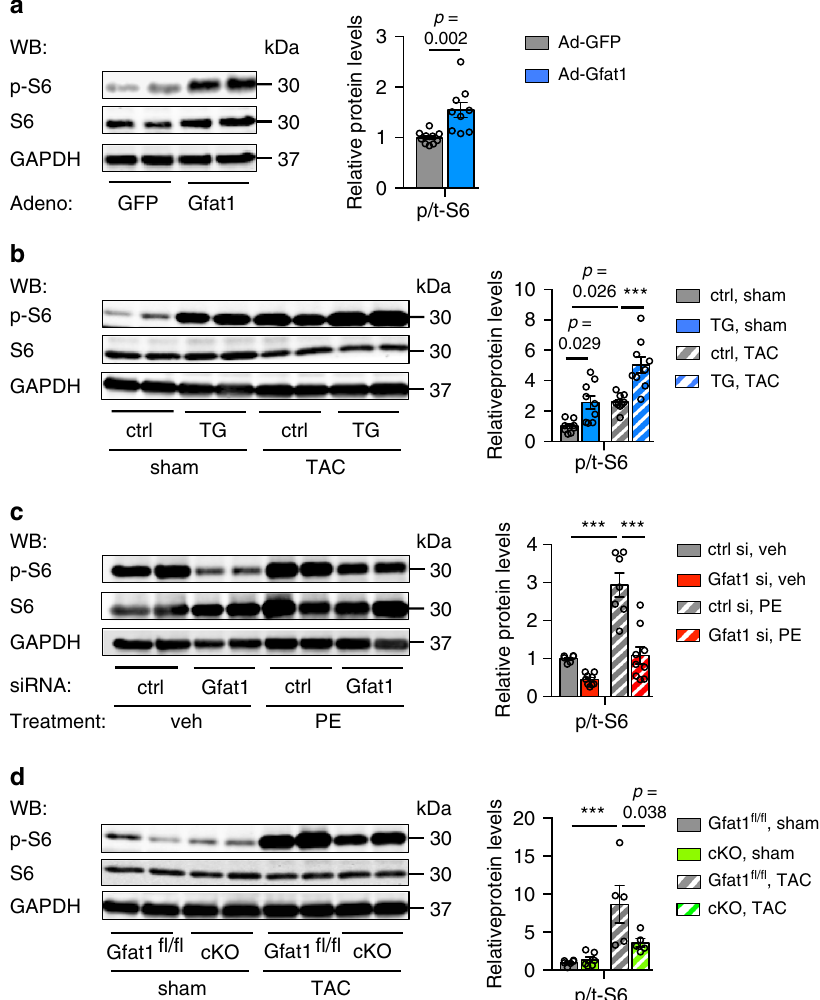
Fig. 7 The HBP stimulates mTOR signaling. a Gfat1 overexpression in NRVMs was suf fi cient to activate mTOR signaling as shown by an increase in S6 phosphorylation, a downstream event of the mTOR pathway. N = 10 for Ad-GFP; n = 9 for Ad-Gfat1. Student ’ s t test (two-tailed) was conducted. b Gfat1 overexpression in the heart led to activation of the mTOR pathway. Gfat1 expression was turned on in the double transgenic mice for 2 weeks. After TAC, the heart was harvested to assess mTOR signaling. Pressure overload caused upregulation of S6 phosphorylation that was further potentiated by Gfat1 overexpression. N = 8 for ctrl/sham; n = 9 for other groups. c Gfat1 silencing in NRVMs diminished the mTOR pathway after PE treatment. N = 6 for ctrl si/veh; n = 9 for Gfat1 si/veh; n = 7 for ctrl si/PE; n = 9 for Gfat1 si/PE. d Cardiac-speci fi c knockout of Gfat1 led to a decrease in the mTOR signaling, as evidenced by reduction in S6 phosphorylation. N = 6 for sham; n = 5 for TAC. Data are shown as mean ± SEM. Signi fi cance was calculated by two-way ANOVA, followed by Tukey ’ s test. *** p < 0.001. Source data are provided as a Source Data fi